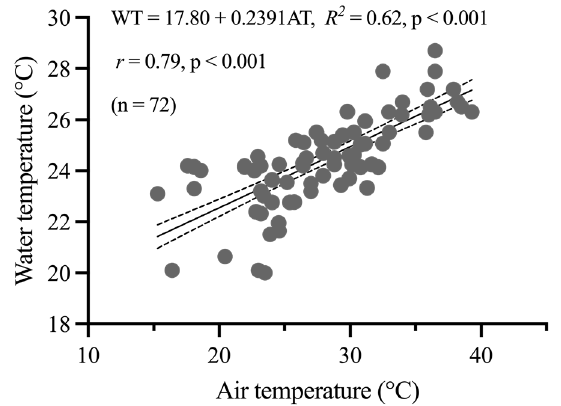
Figure 5. Relationship between daily air temperature (AT) and surface layer water temperature (WT) at Pakkok River during wet and dry season of 2022. The AT and WT water temperature in Pakkok River was monitored at 15th and 28th of each observed month (May, August, November, and February) during 2022 (n = 72).